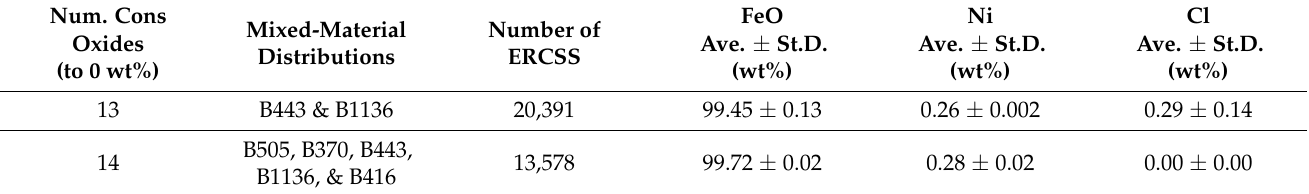
Table 9. Blueberry composition averaged over the second group of complete solution sets (most restrictive constraint set